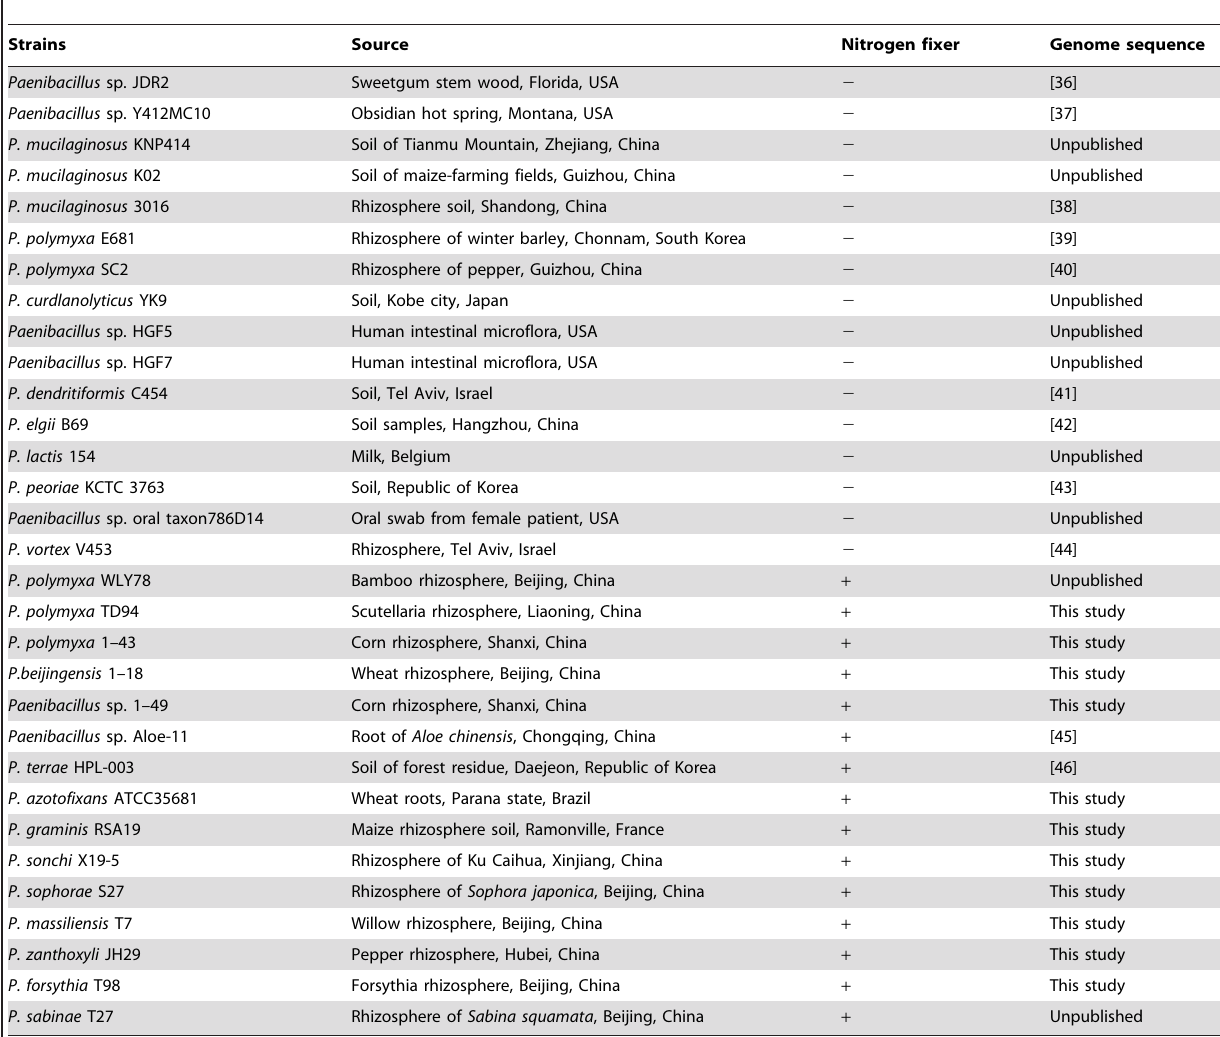
Table 1. Paenibacillus strains used in